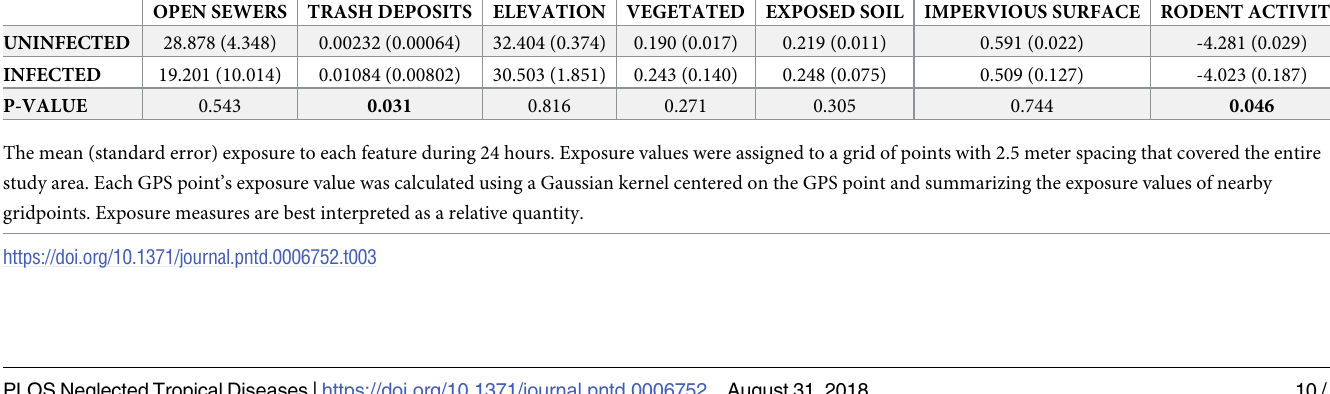
Table 3. Movement-induced exposure to leptospirosis transmission sources, by infection status.